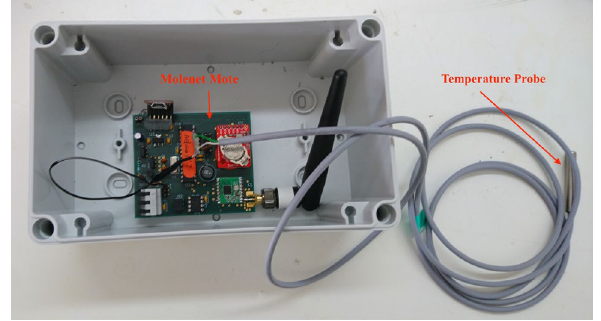
Fig. 6 Temperature-only